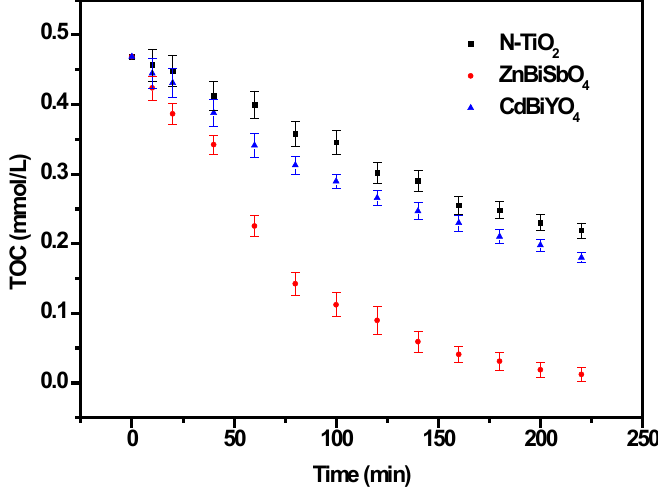
Figure 11. Total organic carbon (TOC) plots during the photocatalytic degradation of IC under visible light irradiation with ZnBiSbO respectively. The results are means of triplicates, and error bars represent ±1 SD.